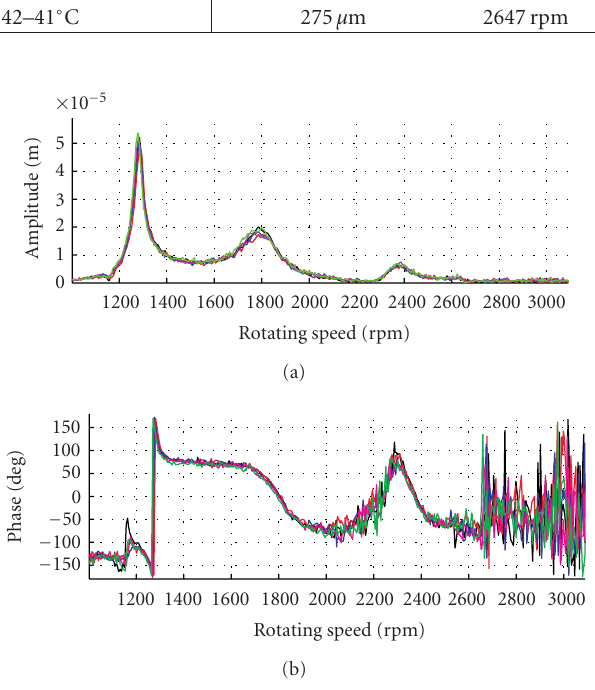
Figure 14: Unbalance responses of the 2nd order during run-up for various bearing temperatures at the bearing support B1 (black line = 30 ◦ C; red line = 35 ◦ C; blue line = 38 ◦ C; magenta line = 40 ◦ C; green line = 42 ◦